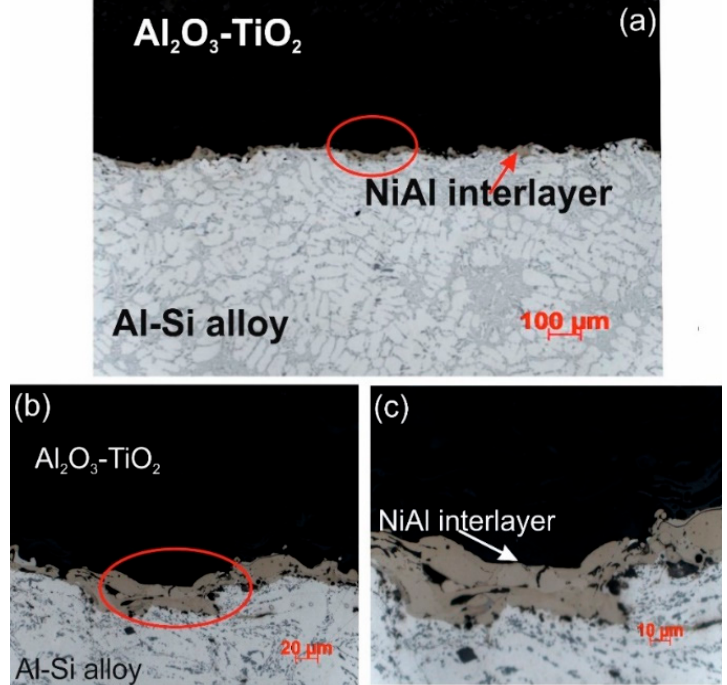
Figure 3. Microstructure of HVOF sprayed Al 2 O 3 -15 wt.% TiO 2 coating with the NiAl interlayer on the Al-Si cast alloy: ( a ) LM image; ( b ) and ( c ) magnified area selected in Figure 3a.